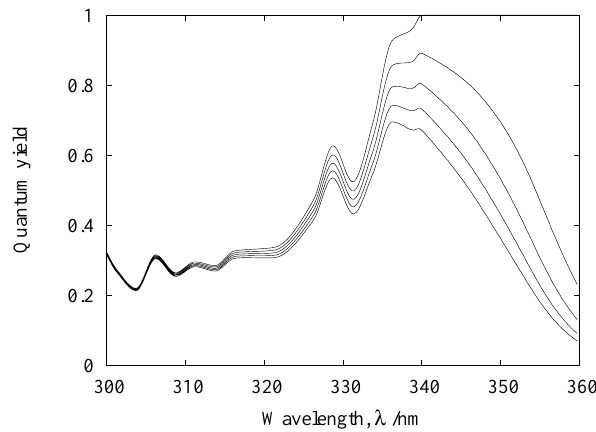
Fig. 5. Molecular channel quantum yield for different pressures. From highest to lowest the lines represent pressures of 0, 250, 500, 750 and